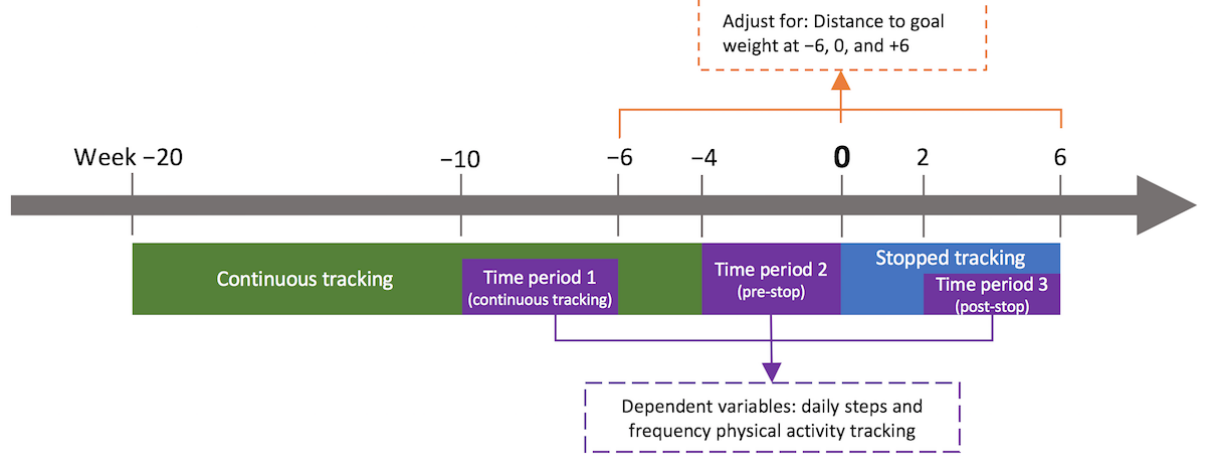
Descriptive statistics explored unadjusted differences in